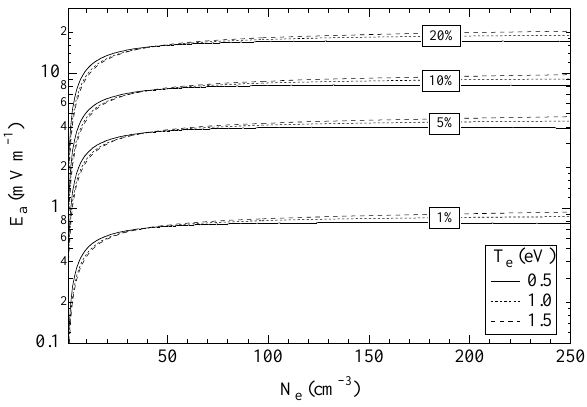
Fig. 11. Levels of spurious electric field which develops when the electron density around P1 differs from that around P2 by a given percentage. The density gradients along the antenna baseline are 1%,5%, 10%, and 20% between 0 and 260 cm − 3 , and the electron temperature is selected between 0.5 eV, 1 eV, and 1.5 eV.